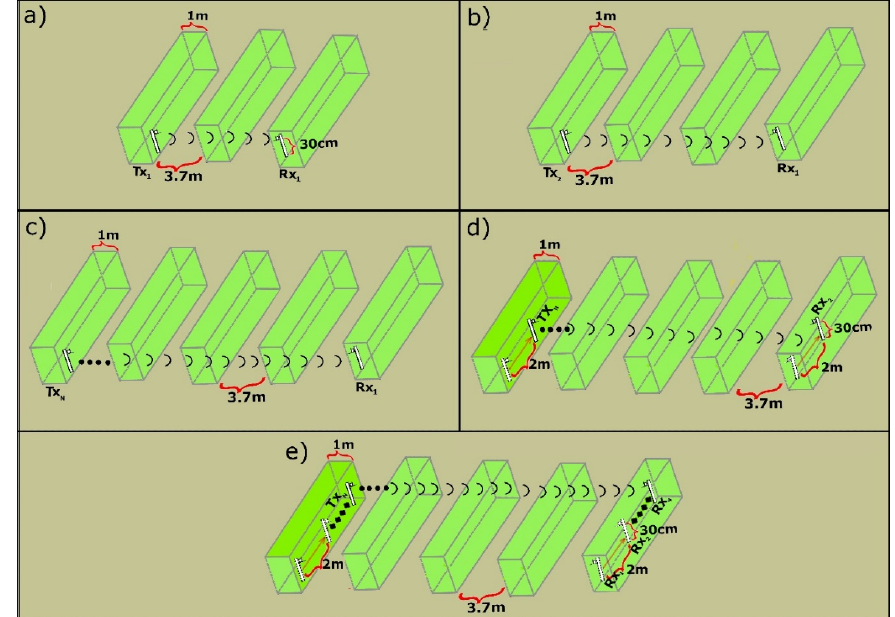
Figure 3. Diagram of measurements stages inside the greenhouse. ( a ) Wireless link arrangement between Tx and Rx nodes when there is one (1) "tomato plant wall" between them ( b ) Wireless link arrangement between Tx and Rx nodes when there are two (2) "tomato plant walls" between them ( c ) Arrangement of wireless link between Tx and Rx nodes when there are three "tomato plant walls" between them ( d ) Change of position at two (02) meters from both Tx and Rx nodes along the aisle ( e ) Change up to four (4) positions along each aisle of the Tx (Tx 1 , Tx 2 , Tx 3 , Tx 4 ) and Rx (Rx 1 , Rx 2 , Rx 3 , Rx 4 ) nodes.